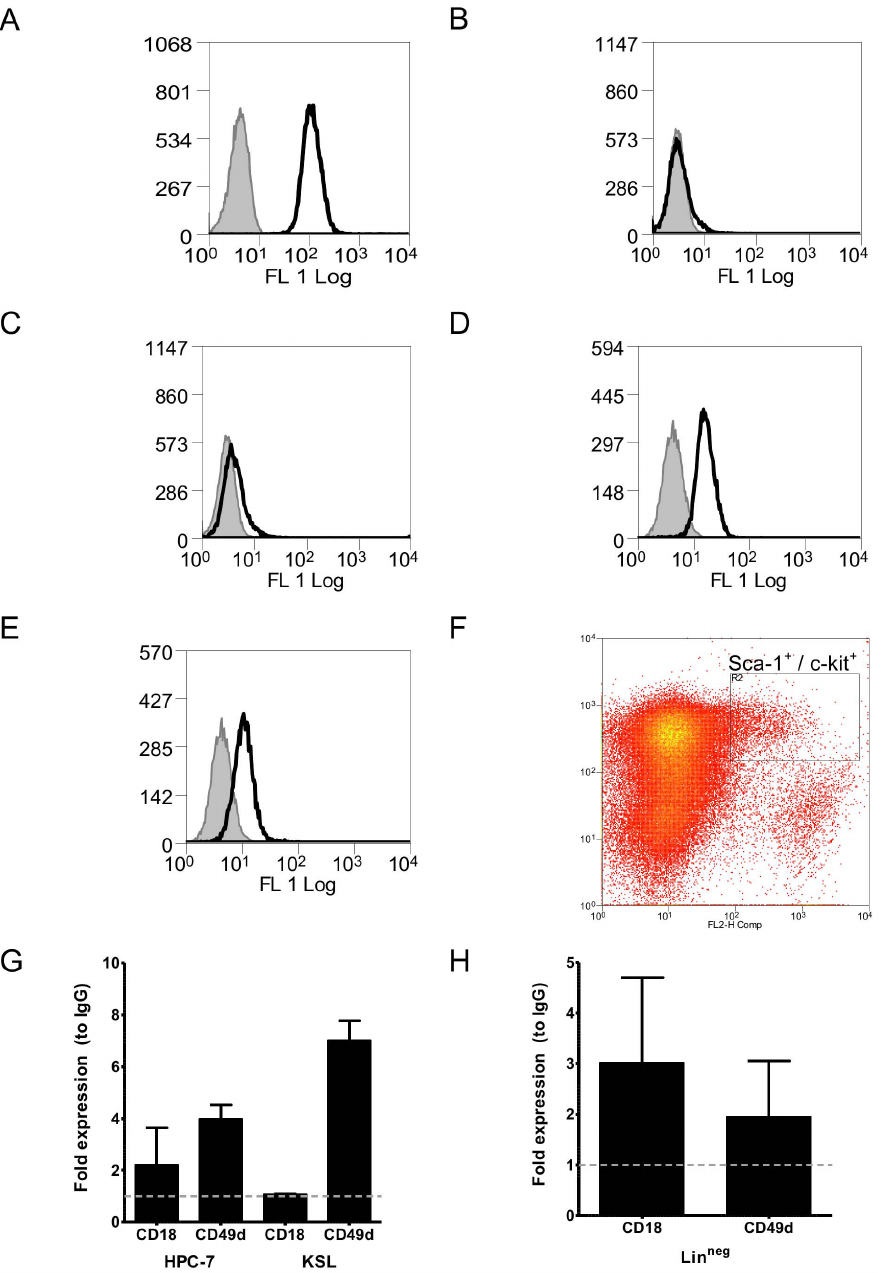
Figure 3. HPC-7 and KSL cells express CD18 and CD49d. HPC-7 cells express (A) CD11a, but not (B) CD11b or (C) CD11c. Flow cytometry also revealed expression of (D) CD18 and (E) CD49d on the surface of HPC-7. (F) Whole bone marrow was depleted for lineage postive cells and labelled for Sca-1, c-kit and either IgG, CD18 or CD49d. The gating used is shown in panel F (FL2: Sca-1; FL3: c-Kit). (G) KSL cells express cell surface CD49d, while CD18 could not be detected. (H) CD18 and CD49d could be identified by flow cytometry following cell